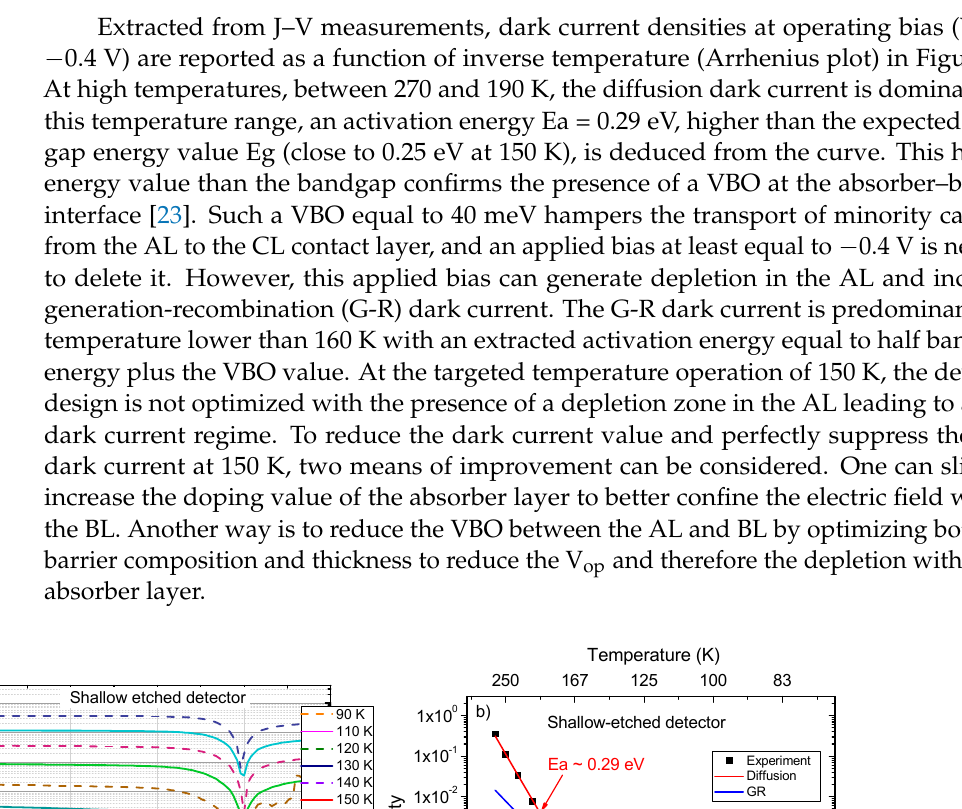
Figure 7. Front-side illuminated spectral quantum efficiency taken at T = 150 K and under different biases of the shallow-etched circular mesa photodetectors with diameter size including the additional lateral diffusion length.